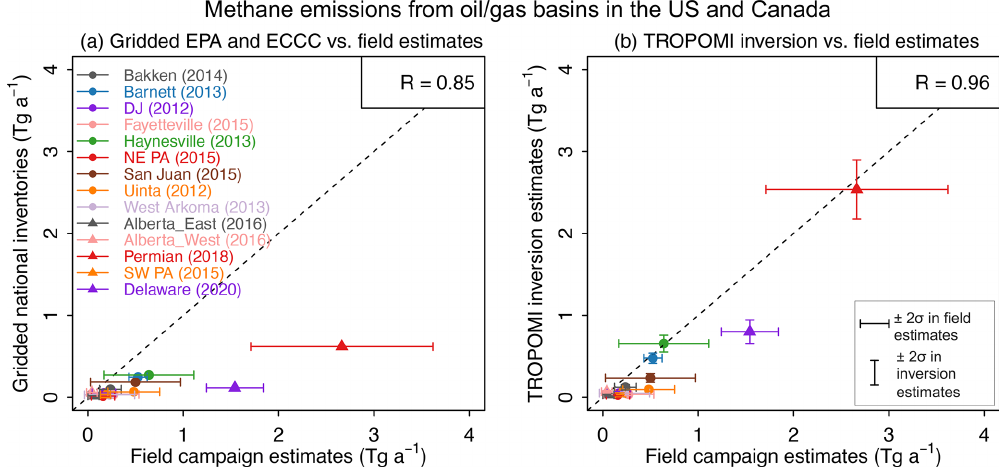
Figure 4. Methane emissions from 14 oil and natural gas production basins in the US. Estimates from field campaigns are compared to the gridded EPA and ECCC inventories for the US and Canada (a) and to results from our TROPOMI inversion using these inventories as prior estimates (b) . The 1 : 1 line is dashed, and correlation coefficients ( R ) are shown in the inset. More details, including references for the field campaigns, can be found in Table S1. Circles represent the same nine basins in Alvarez et al. (2018), and triangles are the new basins included in this